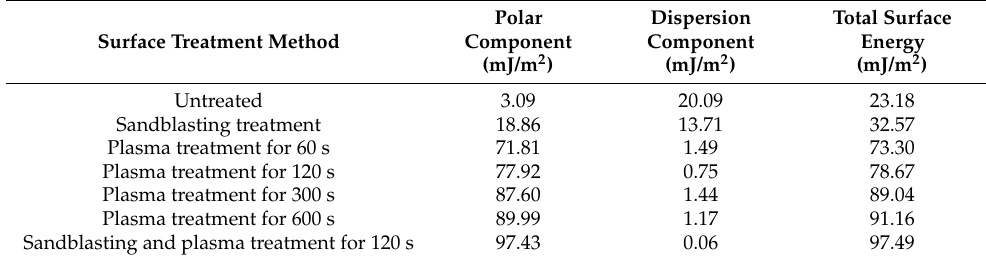
Figure 13. Contact angle between CF/EP surface and ethylene glycol with different surface treatments. ( a ) Untreated, ( b ) sandblasting treatment, ( c ) plasma treatment for 60 s, ( d ) plasma treatment for 120 s, ( e ) plasma treatment for 300 s, ( f ) plasma treatment for 600 s and ( g ) sandblasting and plasma treatment for 120 s. Table 9. Total surface energy, polarity and dispersion components of CF/EP with different sur- face